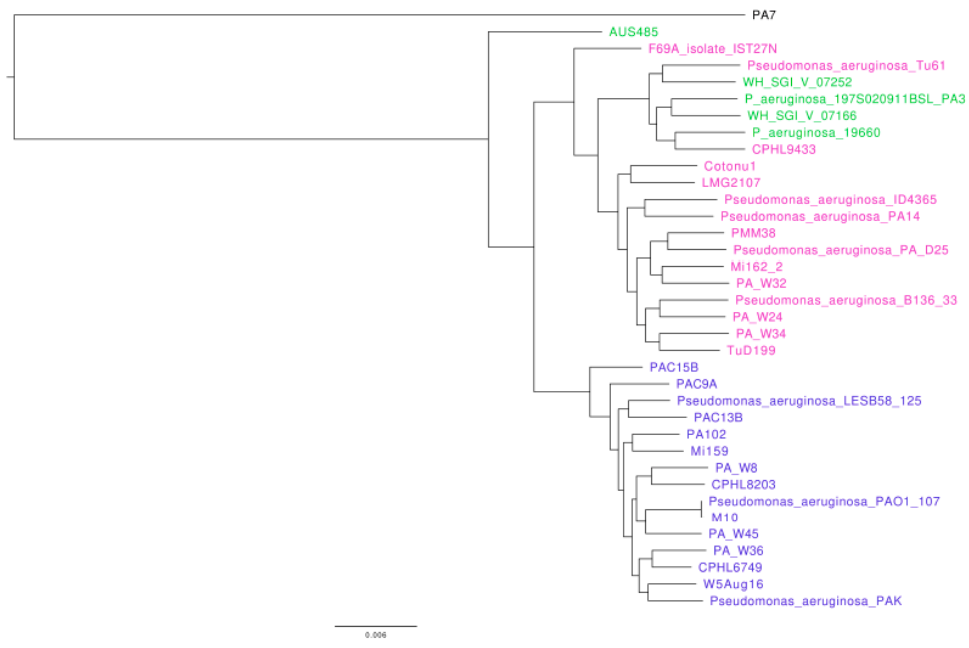
Figure 5. Phylogenetic tree of the whole genome sequence of strains belonging to clade 1, clade 2, and of the putative members of clade 4 . To construct the phylogenetic tree, we retrieved from the NCBI the genome sequences of P. aeruginosa members from clades 1 (shown in blue) and 2 (shown in purple), and candidates of strains belonging to clade 4 (shown in green), as well as PA7 used as outgroup. The accession numbers of the genomes of all strains used are provided in the materials and methods section.